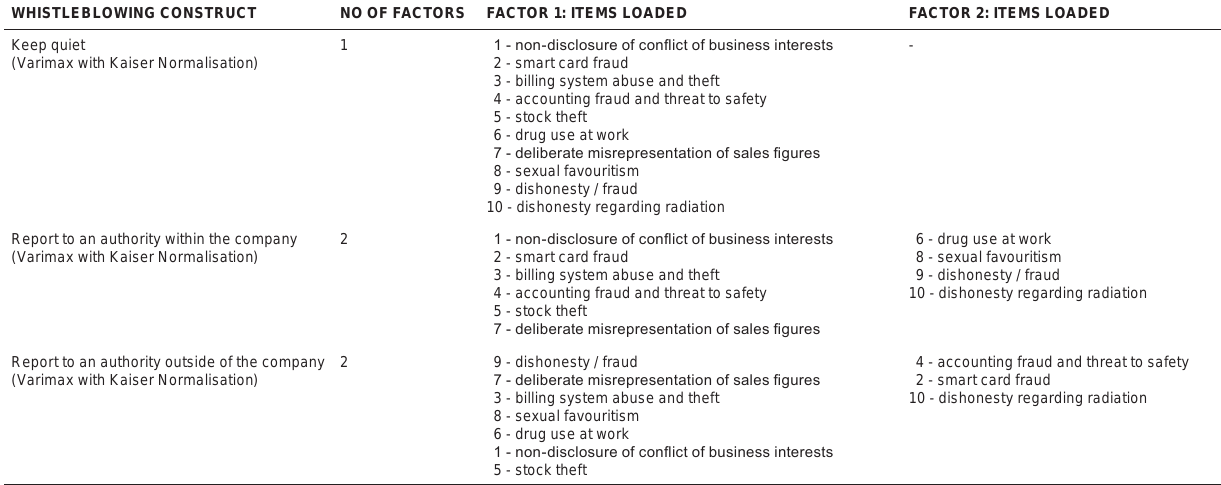
taBle 3 Results of second order factor analysis – three whistleblowing constructs